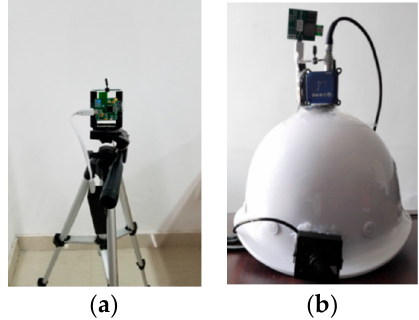
Figure 1. The anchor ( a ) and tag ( b ) hardware devices.